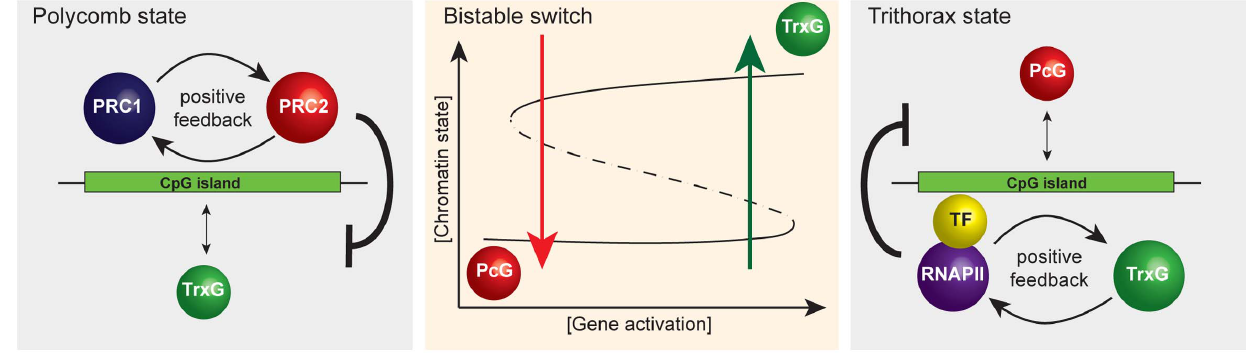
Figure 3. A simplified representation of the responsive model emphasizing that it has properties of a classical bistable switch. A schematic of the proposed bistable switch (center panel). The ground state at CpG island chromatin, PcG occupancy (left panel), is the default that is overcome only when TF-mediated gene activation reaches a critical threshold. Positive feedback mechanisms between PRC1 and PRC2 reinforce PcG occupancy and antagonize the TrxG state. Beyond the activation threshold, the system switches to the TrxG state (right panel) that is in turn reinforced by positive feedback mechanisms between RNAPII and TrxG factors. This, together with TrxG-mediated antagonism of PcG activities, ensures stability of the TrxG state such that stochastic fluctuations in gene activation signal would not trigger a switch back to the PcG state. However, when gene activation signals drop below a critical threshold, the CpG island will switch back to the default PcG state.